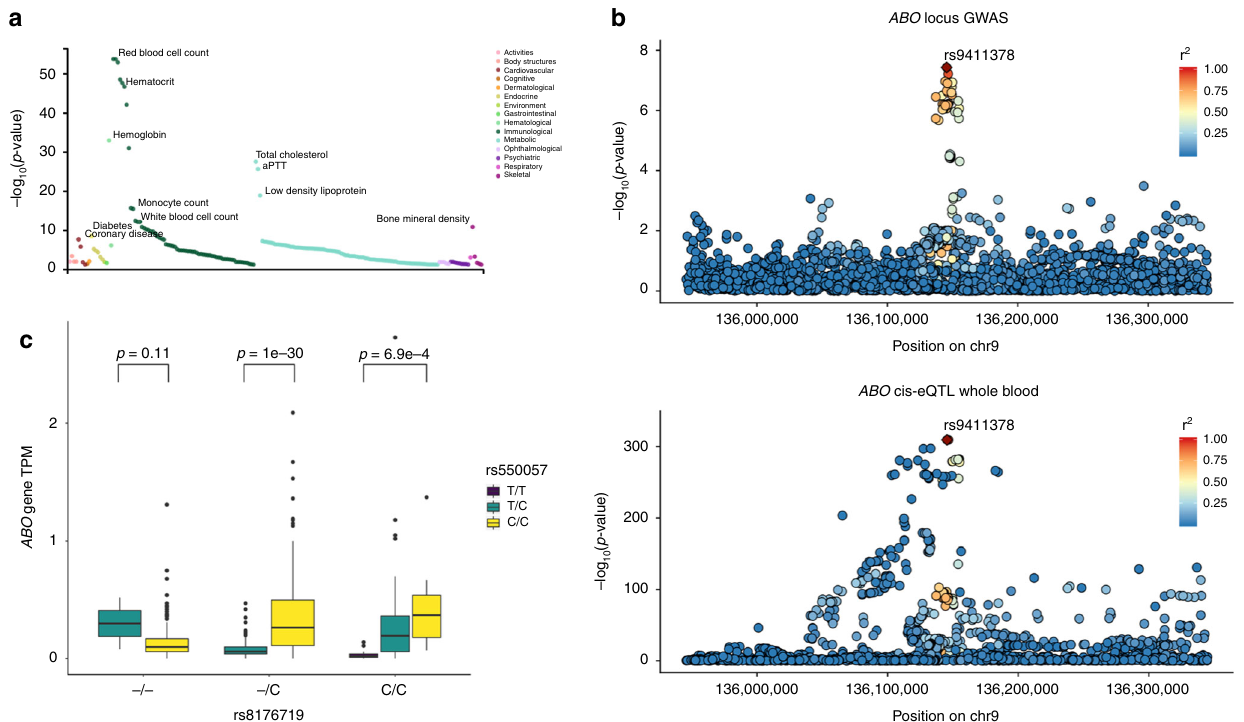
Fig. 5 Functional characterization of the ABO locus. a Phenome-wide association of the rs9411378 SNP across over 4000 GWAS from the GWAS Atlas. b Manhattan plot of the ABO locus overlaying a similar Manhattan plot for the ABO gene eQTL in eQTLGen. r 2 is the 1000 Genomes phase 3 Europeans LD. We see that the signal colocalizes that is con fi rmed by coloc (posterior probability of colocalization 96%). c Expression transcripts per million for the ABO gene in GTEx whole-blood strati fi ed by the genotype of rs8176719 (variant de fi ning blood group O) and rs550057 (variant tagging our sentinel variant rs9411378 (LD r 2 = 0.92 in 1000 Genomes Europeans)) ( n = 670 independent samples). We see that the T allele for rs550057 is associated with